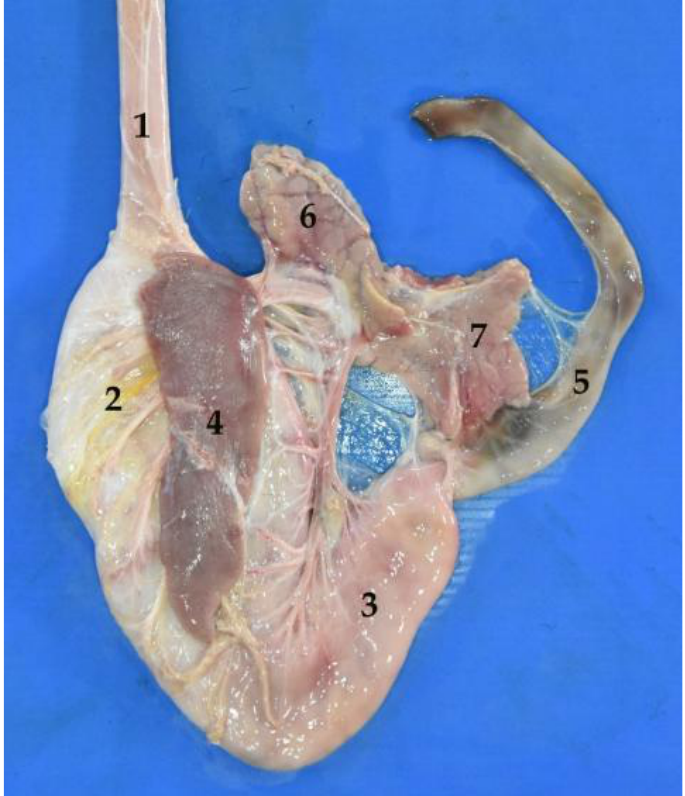
Figure 16. Partial view of the isolated digestive system. ( 1 ) Esophagus; ( 2 ) left part of the stomach; ( 3 ) pyloric part of the stomach; ( 4 ) spleen; (5 ) duodenum; ( 6 ) pancreatic left lobe; ( 7 ) pancreatic right lobe.